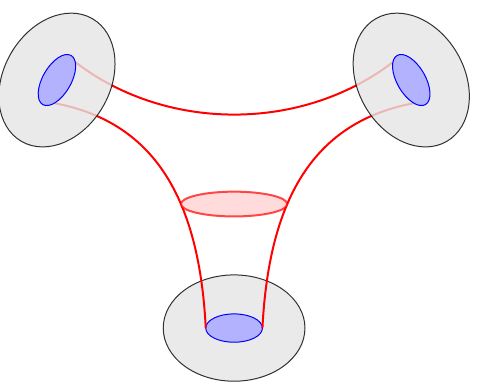
Figure 2. A replica wormhole spacetime that contributes in to the Euclidean path integral for the computation of spectral traces of density